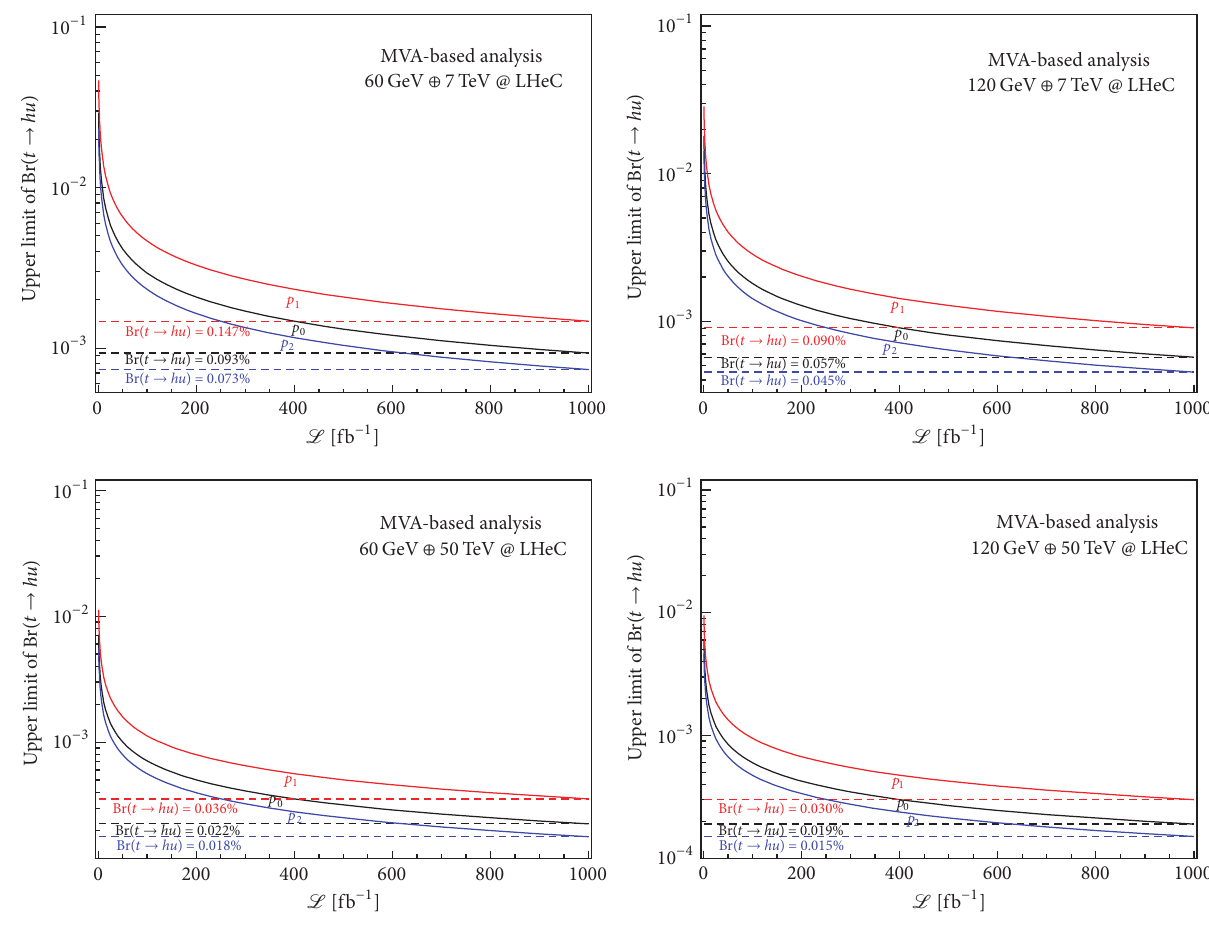
Figure 5: The same as Figure 4 but for MVA.